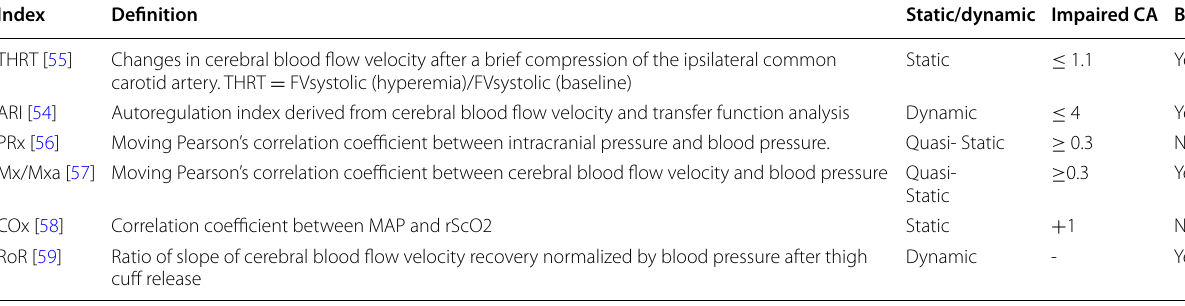
BU , brain ultrasound; THRT , transient hyperemic response test; FV , flow velocity; ARI , autoregulation index; PRx , pressure-reactivity index; Mx , Mean index; COx , cerebral oximetry index; rScO2 , regional cerebral oxygen saturation; RoR , rate of